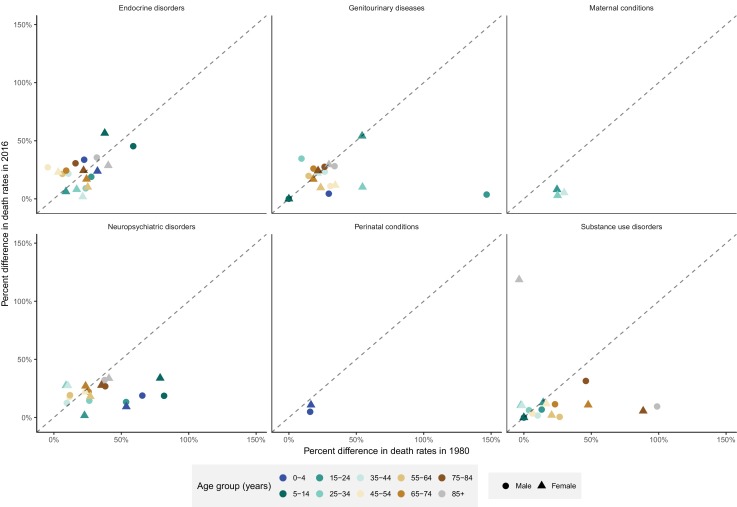
National percent difference in death rates between the maximum and minimum mortality months for the cluster of causes other than cancers, cardiorespiratory diseases and injuries in 2016 versus 1980, by sex and age group.